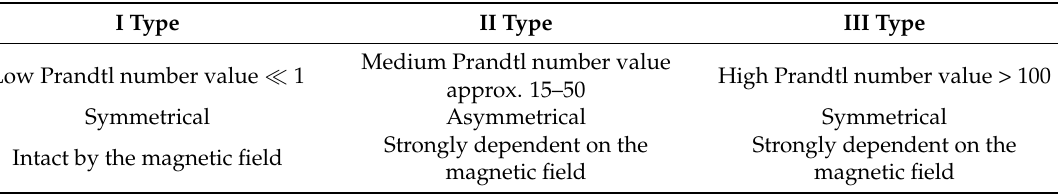
Table 2. General description of flow structure types.